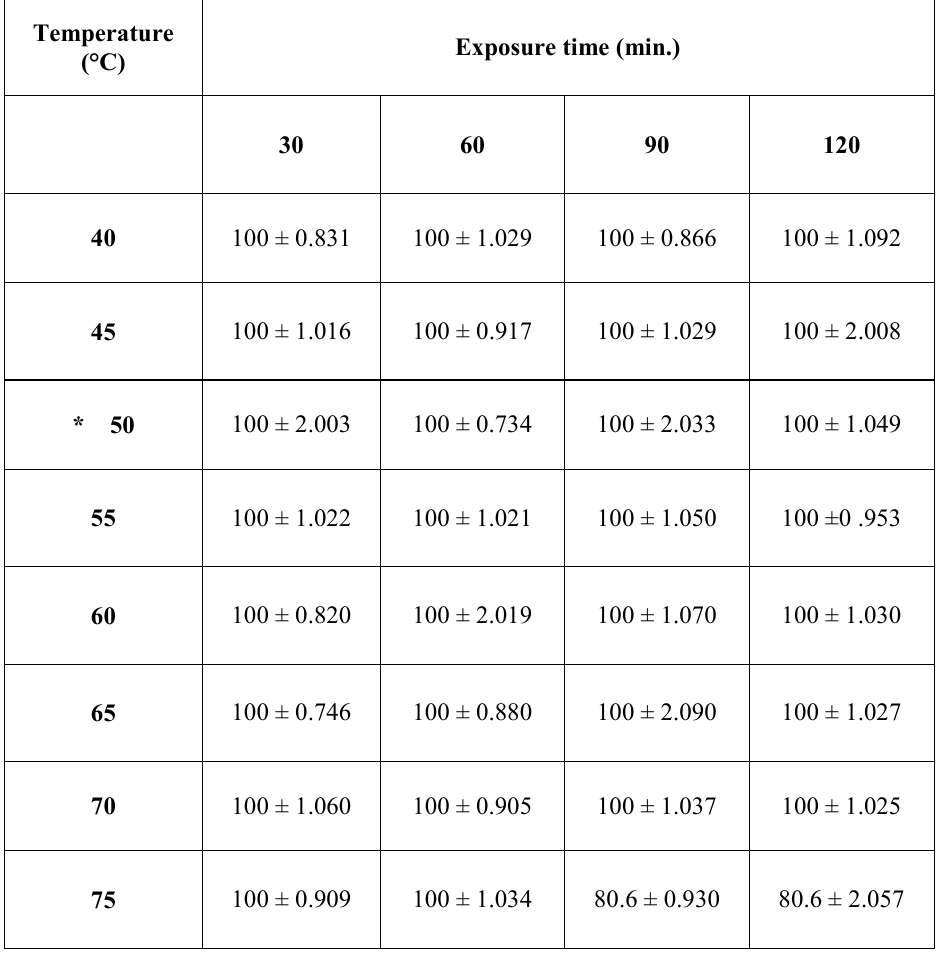
Table 2. Thermal stability of Bacillus subtilis NRC-B233b dextranase. Relative values of dextranase activity of enzyme, expressed in %, and obtained by Berridge’s